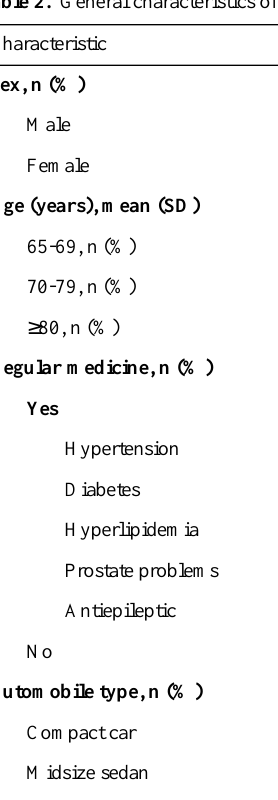
Table 2. General characteristics of the elderly drivers